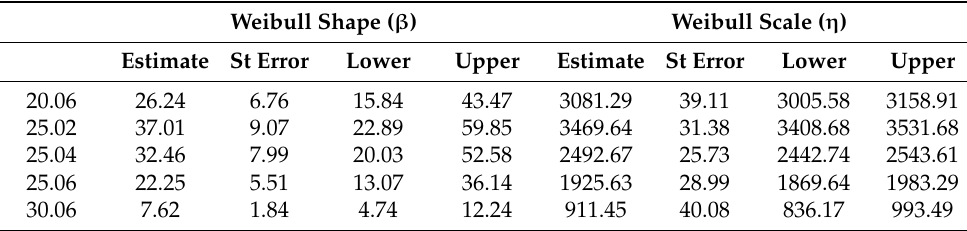
Table 4. The Weibull statistics of the number of cycles to failure for the apical diameter and taper study